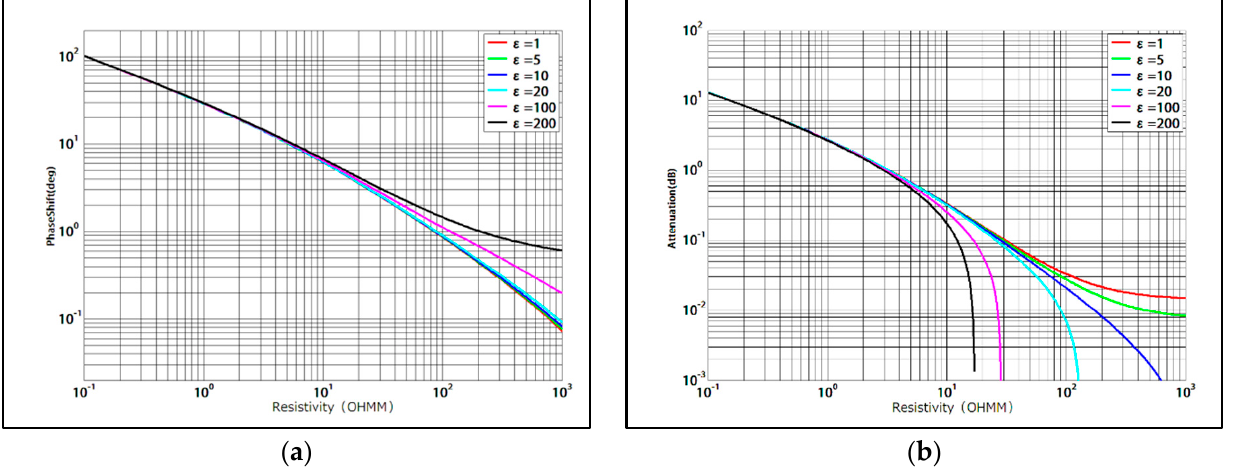
Figure 3. The variation rules of measured signal with permittivity: ( a ) resistivity phase shift; ( b ) resistivity to amplitude a tt enuation.